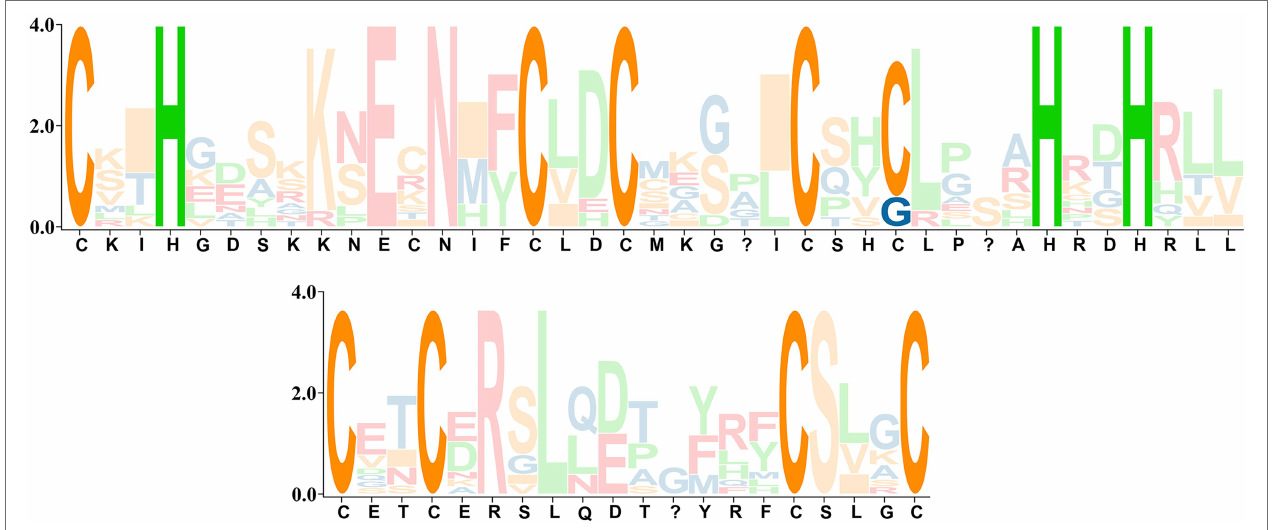
FIGURE 1 | SeqLogo of two conserved regions of the PLATZ transcription factor in